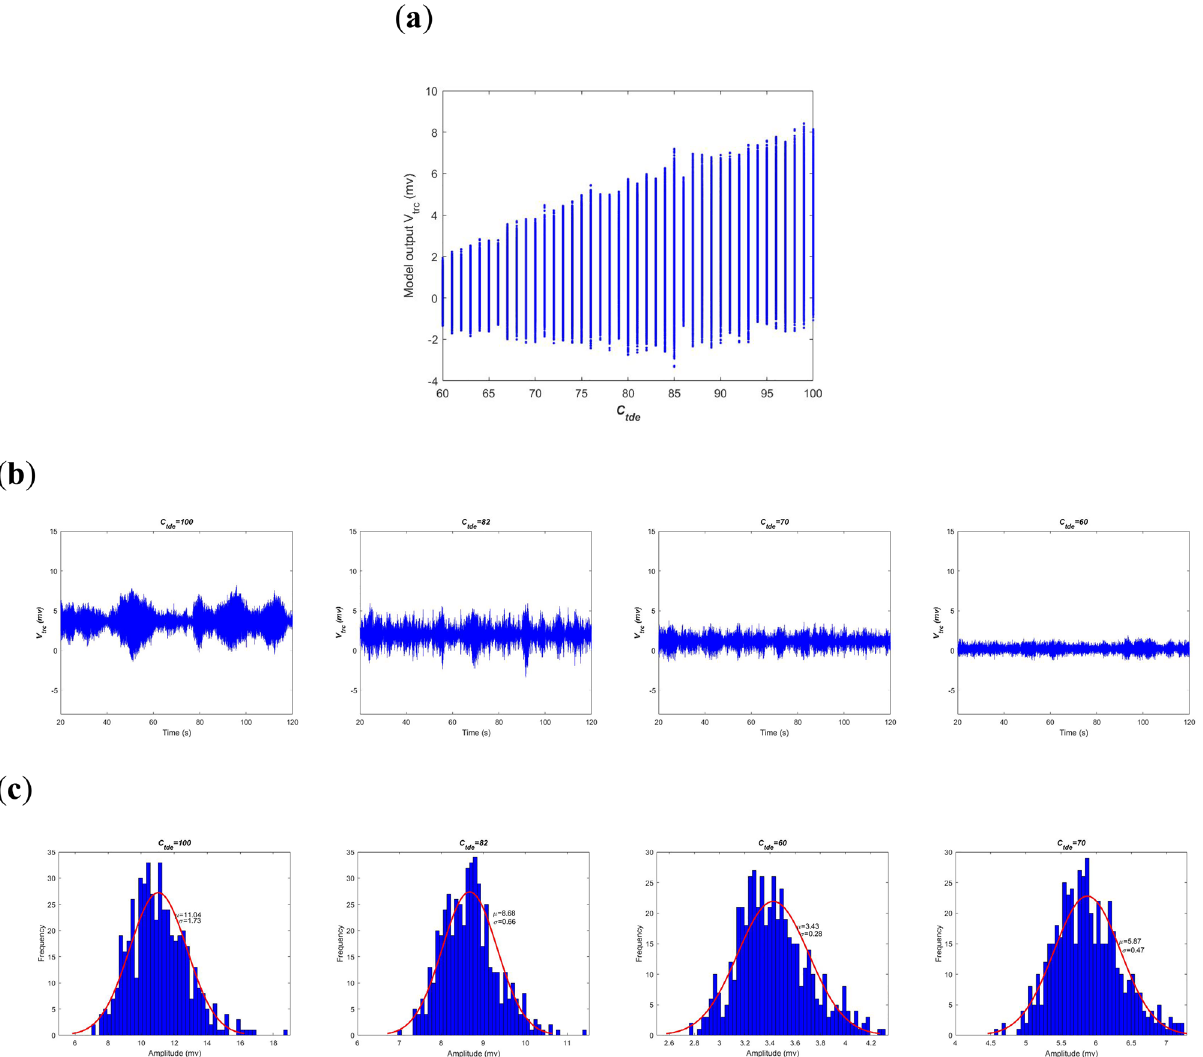
Figure 3. Amplitude analysis of the BTC model output V t in time-domain when the excitatory synapse connectivity parameter C tde from PNN to TRC is varied in the range of [60, 100]. ( a ) The model output of the summated postsynaptic potential V t for each C tde . ( b ) Diagram of the summated postsynaptic potential V t during [20, 120]s when C tde takes some different values of 100, 82, 70 and 60. ( c ) Amplitude distribution of V t based on 500 realizations of postsynaptic potential when C tde takes some different values of 100, 82, 70 and The longitudinal coordinate (y-axis) of this figure is the summated postsynaptic potential V t during [20, 120]s of simulations. Obviously, as a whole the oscillation amplitude of V t is getting smaller upon decreasing the synapse connectivity parameter C tde . To visualize this result, the detailed postsynaptic potential V t for some typical syn- aptic strengths such as C tde = 100, 82, 70 and 60 is also depicted in Fig. 3b. one can qualitatively observe that the oscillation amplitude of V t is gradually reduced with the decrease of connectivity parameter. Especially, for the two former ones the BTC model produces rhythmic oscillation of potential analogous to alpha-rhythm (with the dominant frequency within alpha band as shown in Fig. 2b), i.e., they exhibit waxes and wanes in amplitude just like a form of spindle 32 . There is no obvious qualitative change in dynamics from the perspective of time series. As the synapse connectivity C tde is less than the critical value of 80, the output of BTC model in the latter two panels presents rhythmic oscillation of the theta frequency band (with the dominant frequency within the theta band as shown in Fig. 2b) with relative small amplitude compared to the former two cases. Due to the influence of the noise, statistical and uncertainty analysis is performed in order to avoid the randomness. Furthermore, as displayed in the Fig. 3c the statistical property of oscillatory potential is characterized by amplitude distribution based on 500 realizations of postsynaptic potential. Here the histogram of oscillation amplitude is fitted by normal density function with estimated parameters of mean and variance. As can be seen in the Fig. 3c, the estimated mean of oscillation amplitude is 11.04, 8.68, 5.87 and 3.43 when the connectivity parameter C tde is successively taken as 100, 82, 70 and 60. This result further quantitatively confirms that the reduced oscillation amplitude of the model output results from the decreased excitatory synapse connectivity parameter C tde , i.e., a hallmark of deficit cholinergic synapse pathway from the PNN population to the TRC population.